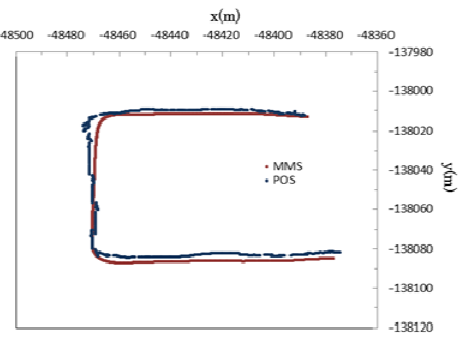
Figure 6. Experimental site